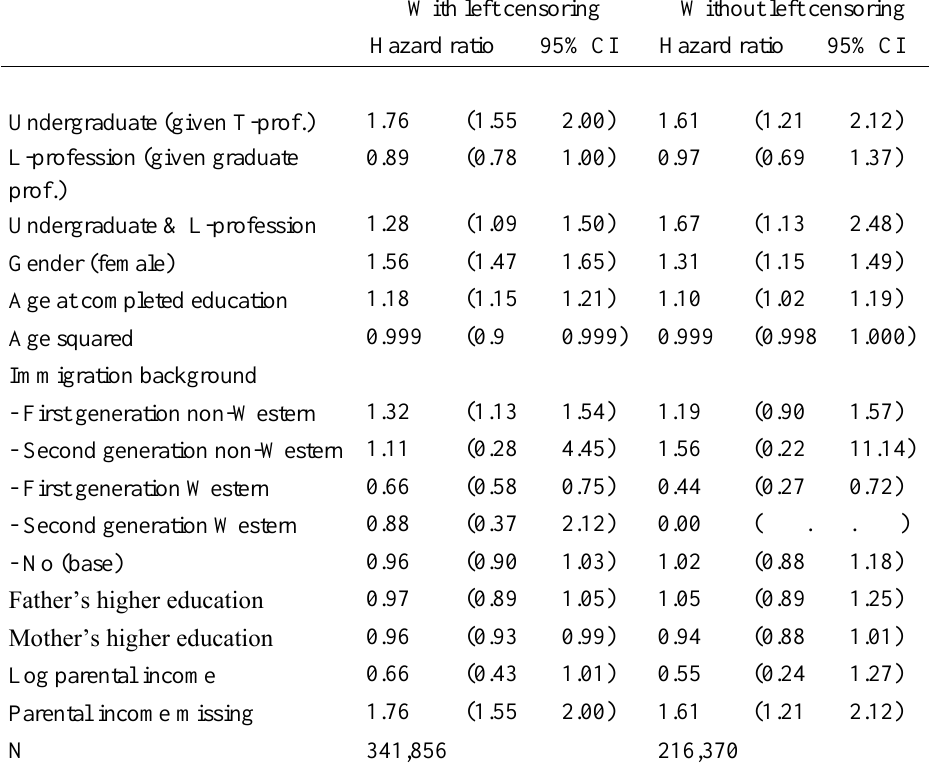
Relative risk (hazard ratio) of receiving a disability pension according to type of profession, gender, age at completed education, immigration background, parental education and income, and birth year (fixed effects, not reported); Cox proport- ional regression model; Norway, 1992–2008. N = 341,856 (with left censoring, including all observations) and 216,370 (without left censoring, excluding all observations with completed education before